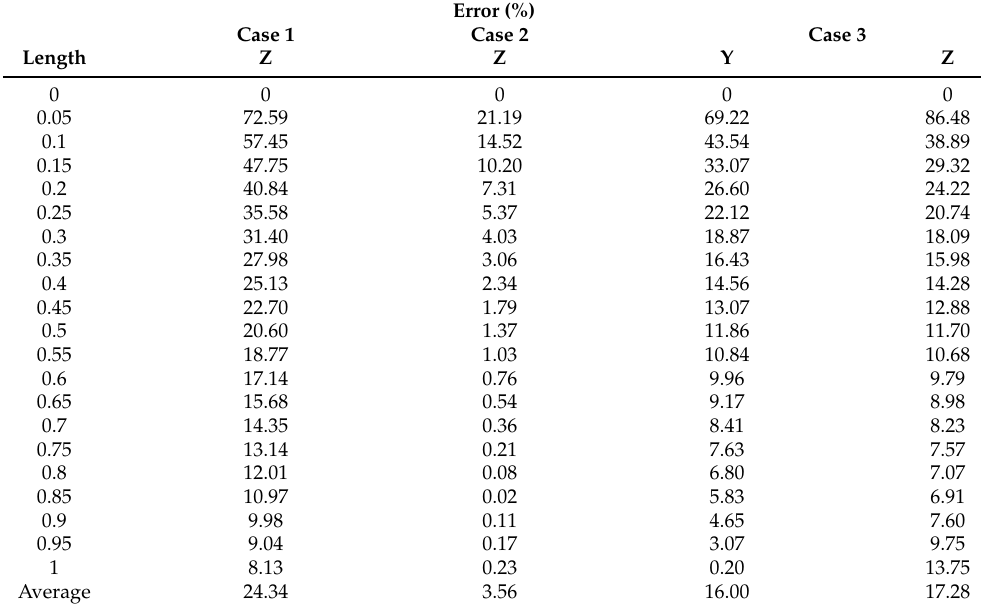
Table A2. Ful error table for double fixed beam.